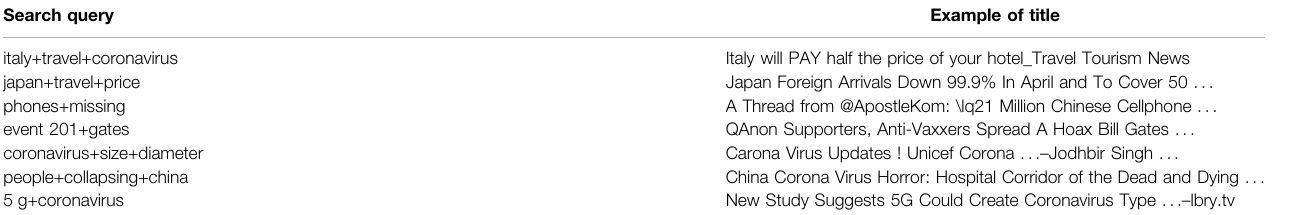
TABLE1| Searchqueriessubmittedtowebsearchenginesandmetainformationresults.Theresultsofasearchqueryareoftenreturnedasalistofmetadata,andtheymay consist of web pages, images, and other types of fi les with helpful information. Search query